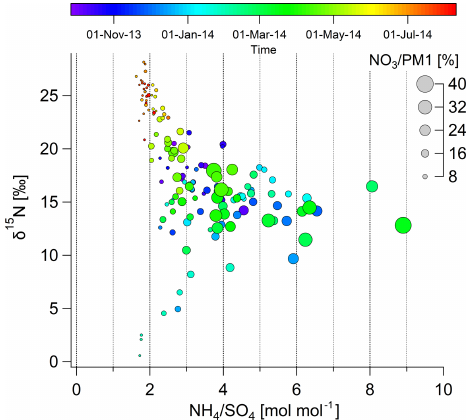
Figure 8. Relationships between δ 15 N of TN and molar ratios of / SO 2 − NH + in particles. The larger circle indicates higher nitrate 4 4 content in PM 1 . The color scale reflects the time of sample collec-